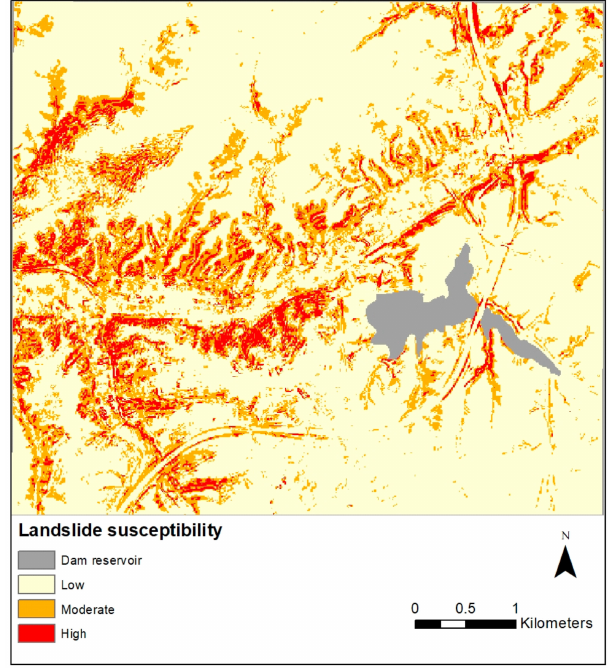
Figure 16. Landslide susceptibility map of the study